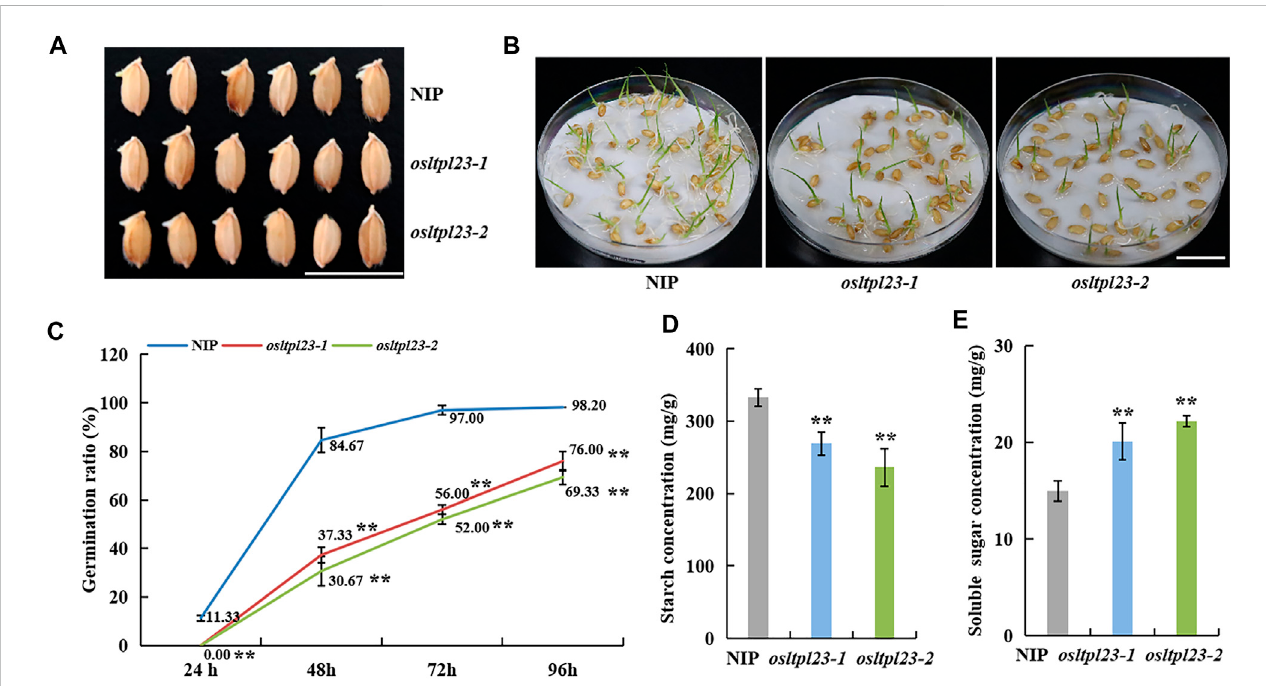
FIGURE 5 OsLTPL23 positively regulates rice seed germination. (A) Phenotypesof germinated seeds of NIP, osltpl23-1 and osltpl23-2 plantsafter 3 days. Scale bar, 2 cm. (B) Phenotypesofgerminated seeds ofNIP, osltpl23-1 and osltpl23-2 plants after 6 days. Scalebar, 2 cm. (C) Germination percentageofwild-type NIP, osltpl23-1 and osltpl23-2 mutant plants. (D) Starch content determination of dry seeds in NIP, osltpl23-1 and osltpl23-2 plants. (E) Soluble sugar content determination of dry seeds in wild-type NIP, osltpl23-1 and osltpl23-2 plants. Values are the mean ±standard deviations of three biological replicates. Signi fi cance were generated by Student ’ s t -test with * p < .05 and ** p <